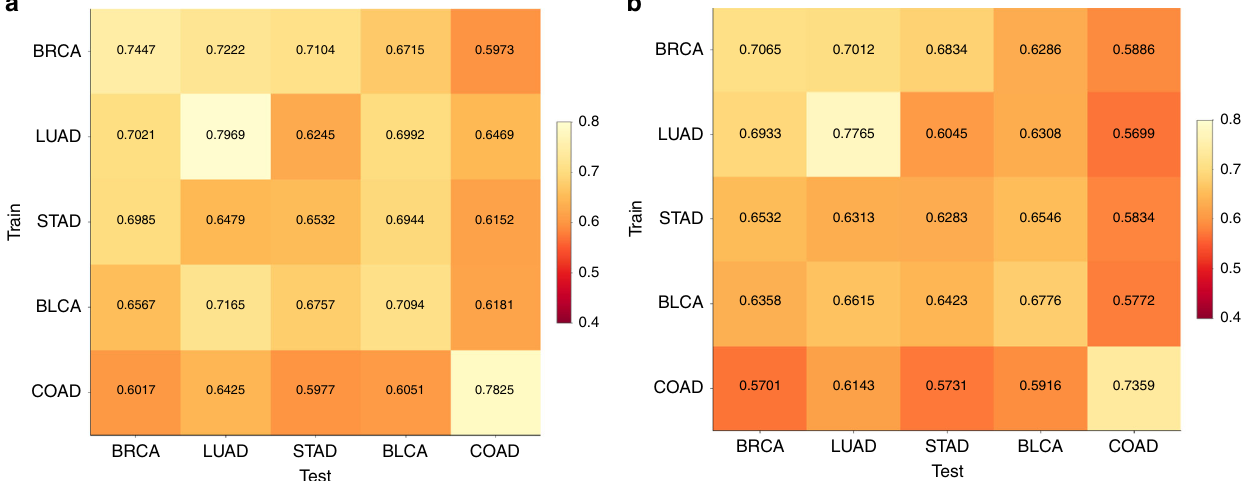
Fig. 7 Classi fi cation of TP53 mutation status for TCGA cancer types BRCA, LUAD, BLCA, COAD and STAD. Cross- and self-classi fi cation AUC values from balanced deep learning models (with 95% CIs) are given ( a ) per-slide and ( b ) and per-tile. sample as cancer. Analogously, the BRCA-trained TP53 mutation however, is that the spatial variation within heatmaps may re fl ect status model predicts patterns similar to the LUAD-trained TP53mut-associated microenvironmental features rather than model. Importantly, the tumor/normal and TP53mut/wt classi- genetic variation among cancer cells. fi ers highlight different regions, indicating these classi fi ers are utilizing distinct spatial features. A caveat to these analyses, NATURE COMMUNICATIONS| (2020) 11:6367